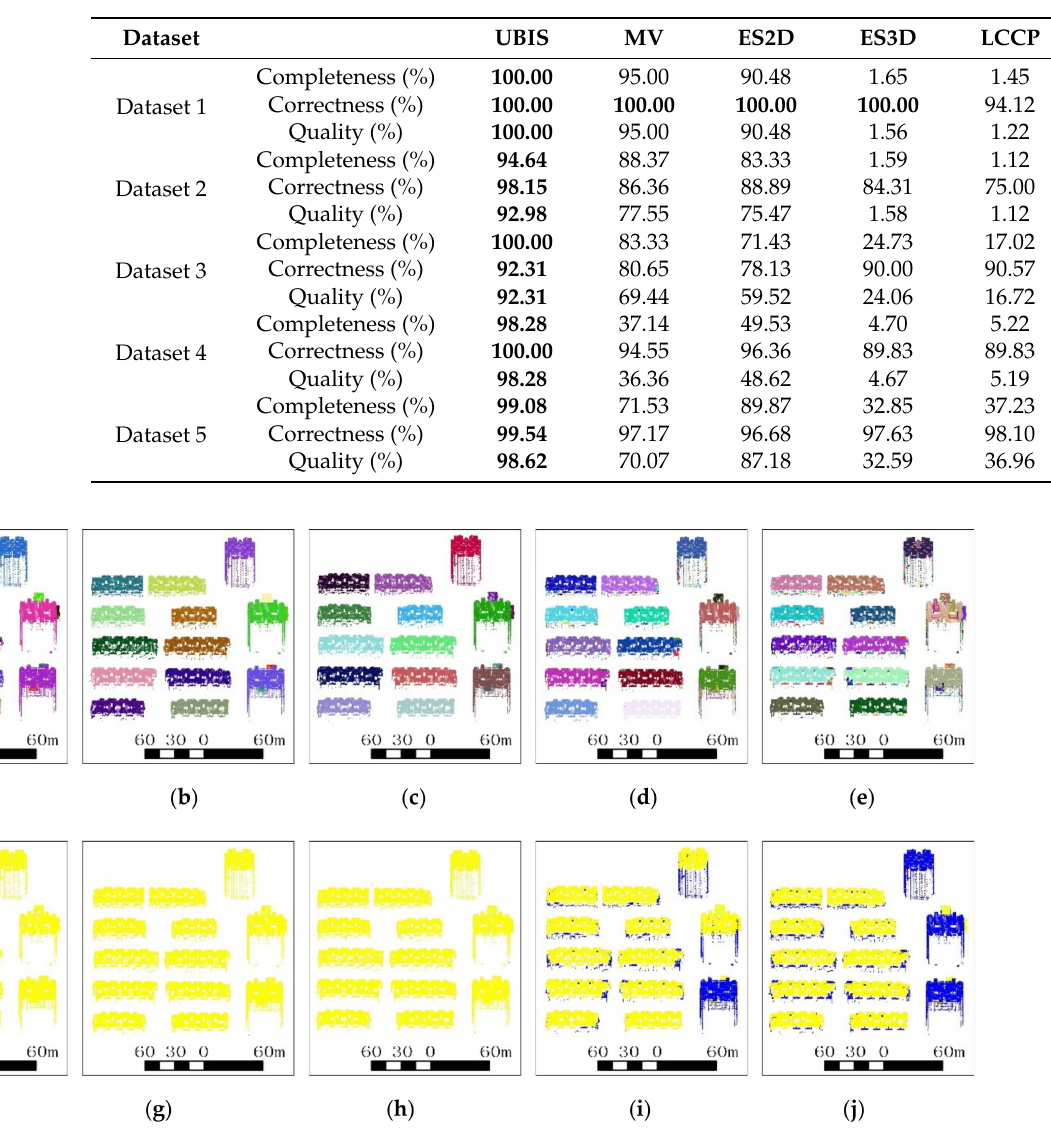
Table 3. Performance comparison of building instance segmentation results.